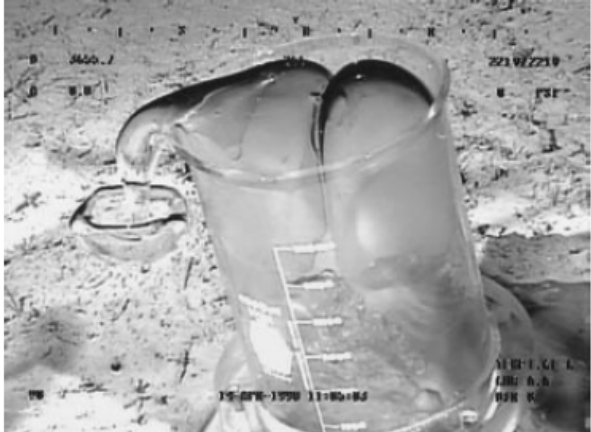
Fig. 8. From Brewer et al. (1999). An experiment in deep ocean fossil fuel CO 2 disposal. A 4L laboratory beaker was placed on the Figure 8. From Brewer et al. (1999). An experiment in deep ocean fossil fuel sea floor at 3.650m depth and about 2L of liquid CO 2 dispensed CO2 disposal. A 4 liter laboratory beaker was placed on the sea floor at 3,650m into it to observe hydrate formation effects and test theory. A CO 2 depth and about 2 liters of liquid CO dispensed into it to observe hydrate hydrate “ice storm” occurred at the interface and slush of solids 2 accumulated at the bottom, pushing excess liquid out of the top. A formation effects and test theory. A CO hydrate “ice storm” occurred at the 2 large fish and other deep-sea animals came by. This image captured interface and slush of solids accumulated at the bottom, pushing excess liquid significant attention and also aroused latent concerns. out of the top. A large fish and other deep-sea animals came by. This image captured significant attention and also aroused latent concerns. Figure 9. The Biosphere 2 giant mesocosm unit in which the first experimental Fig. 9. The Biosphere 2 giant mesocosm unit in which the first ex- tests of the impact of high CO 2 levels on calcification in marine corals was made perimental tests of the impact of high CO 2 levels on calcification in (Langdon et al., 2000). Their data (lower panel) showed a strong relationship marine corals was made (Langdon et al., 2000). Their data (lower between the ion product of calcium carbonate (aragonite) and calcification rate, leading to a prediction of “a decrease in coral reef calcification between the years panel) showed a strong relationship between the ion product of cal- 1880 and 2065 … of 40%.” cium carbonate (aragonite) and calcification rate, leading to a pre- diction of “a decrease in coral reef calcification between the years 1880 and 2065 ... of